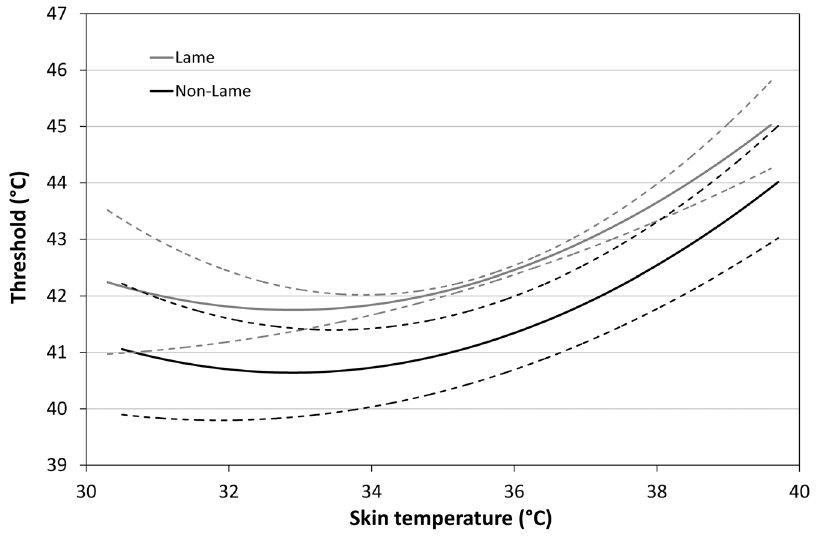
Figure 2. Effect of skin temperature on threshold. For lame and non-lame birds, the modelled predictions ( + / 2 95% CI) of the effect on thermal nociceptive threshold of skin temperature (keeping other factors in the model at their reference values).